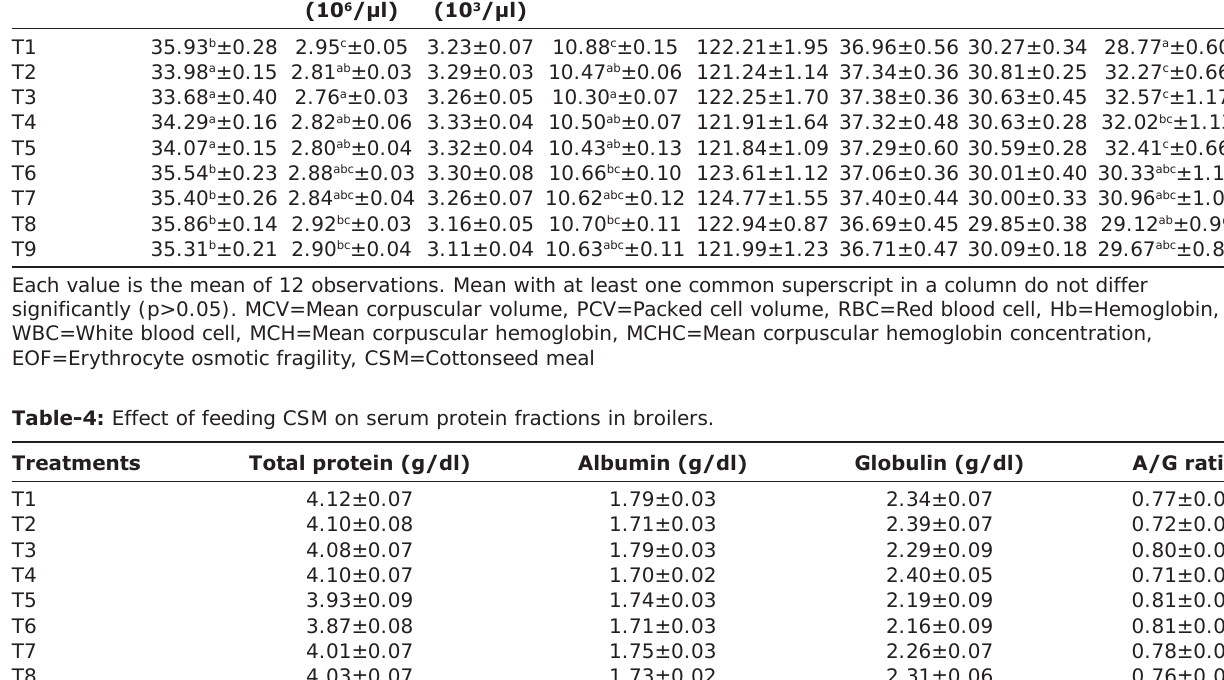
Table-3: Effect of feeding CSM on hematological parameters in broilers. Treatments PCV